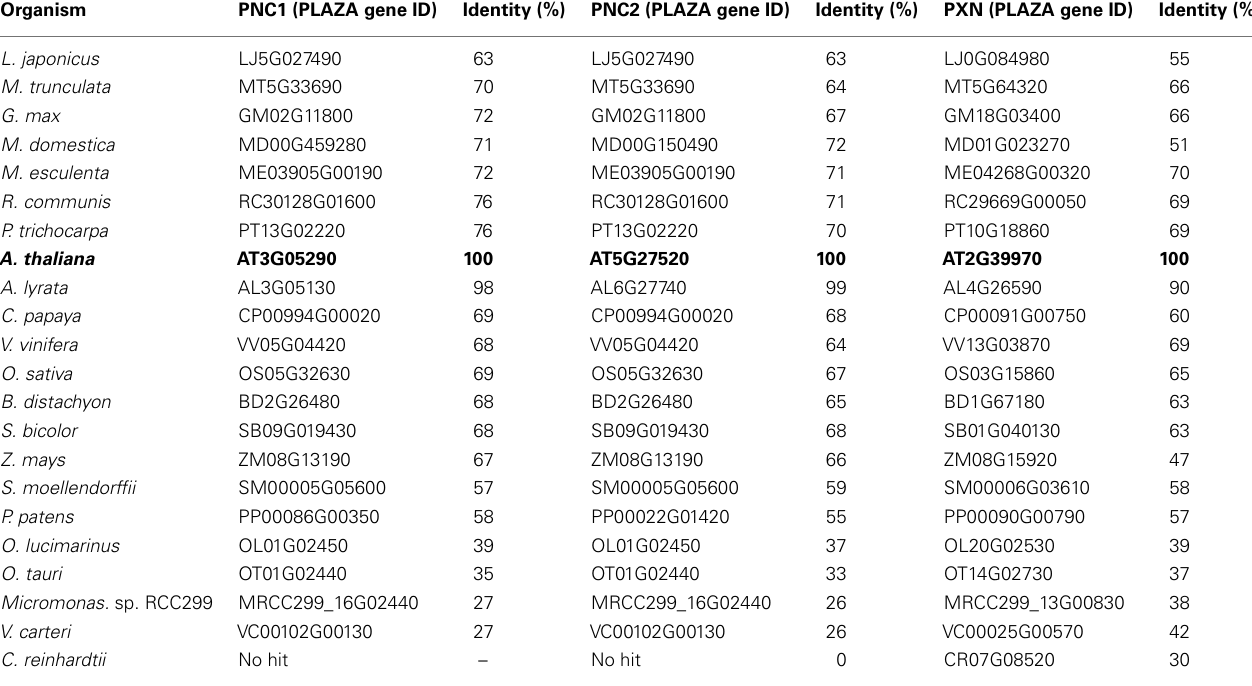
Table 2 | Plant homologs of the peroxisomal MC-type transporter from Arabidopsis